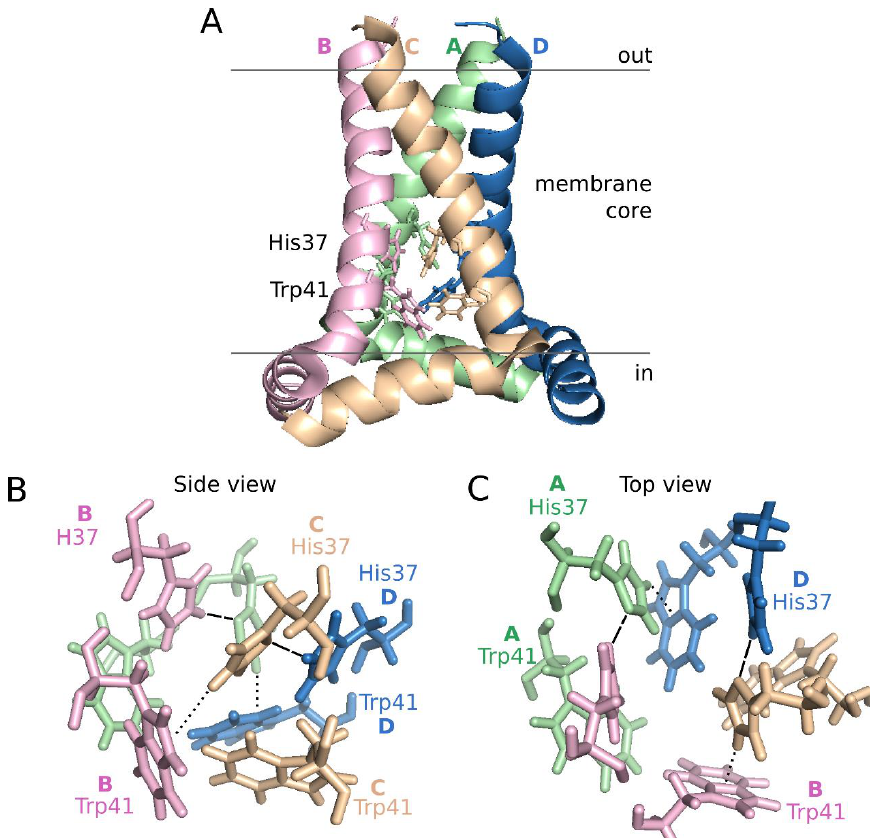
Figure 5. Influenza A M2 structure at pH 7.5. Schematic representation of the influenza A proton channel (Residues 22–62) based on the 2L0J structure [96]. A. Lateral view of the M2 tetramer. Monomers, from A to D are depicted in green, pink, pale orange and blue, respectively, using a cartoon representation. The side chains of His37 and Trp41 are highlighted in lines using the same color code. B and C. Side and top view representations of the HxxxW quartet, respectively. Dashed lines indicate hydrogen bonds, dotted lines cation-π interactions.